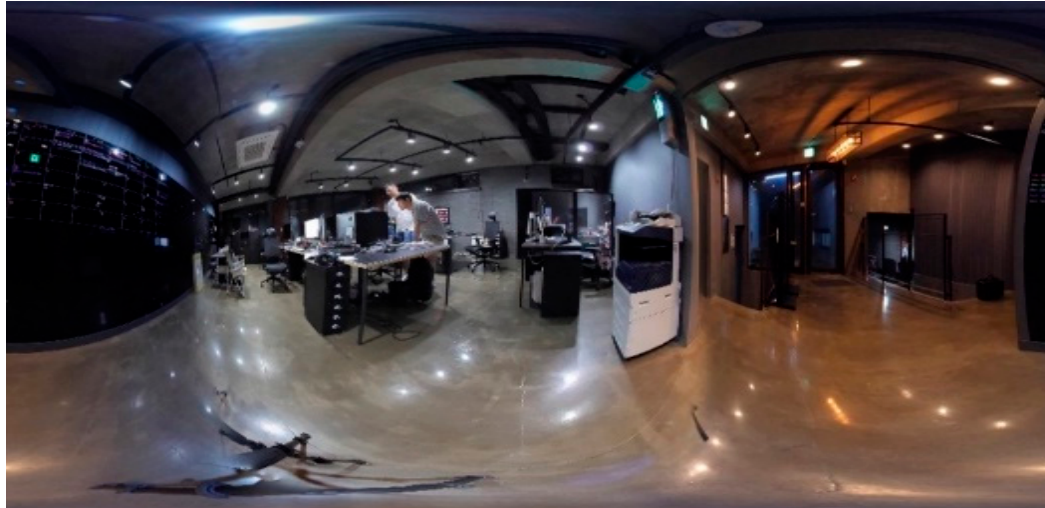
Figure 11. The Right-view stereo panorama created by our proposed system.